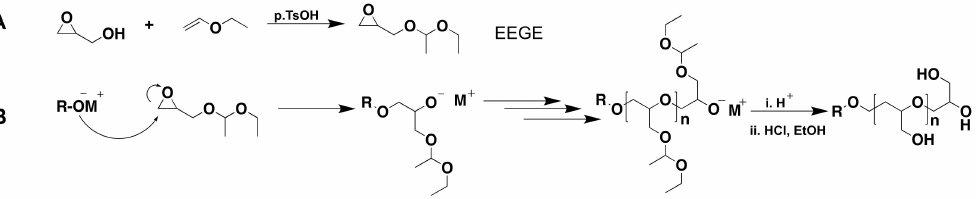
Figure 4. ( A ) Protection of glycidol, ( B ) polymerization of EEGE, and acidic deprotection of acetal groups. Adapted with permission from refs. [36,37]. Copyright 2010 American Chemical Society; 2021 Wiley Online